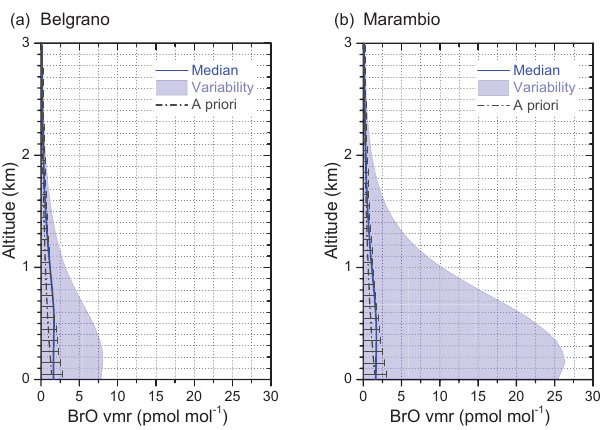
Figure 10. Vertical profile of the BrO volume mixing ratio in the Antarctic troposphere (2015). The observations performed from Belgrano station are shown in (a) while those performed from Marambio are given in (b) . The median BrO values retrieved are in- dicated in thick blue lines while the shaded blue areas mark the vari- ability range of BrO vmr throughout the sunlit period (SZA<75 ◦ ). The a priori BrO profiles (and error) used in the inversion are shown in dark grey. The vertical grid of the retrieval (100m) is indicated with the small ticks on the vertical axis. Note the same scales in both plots.